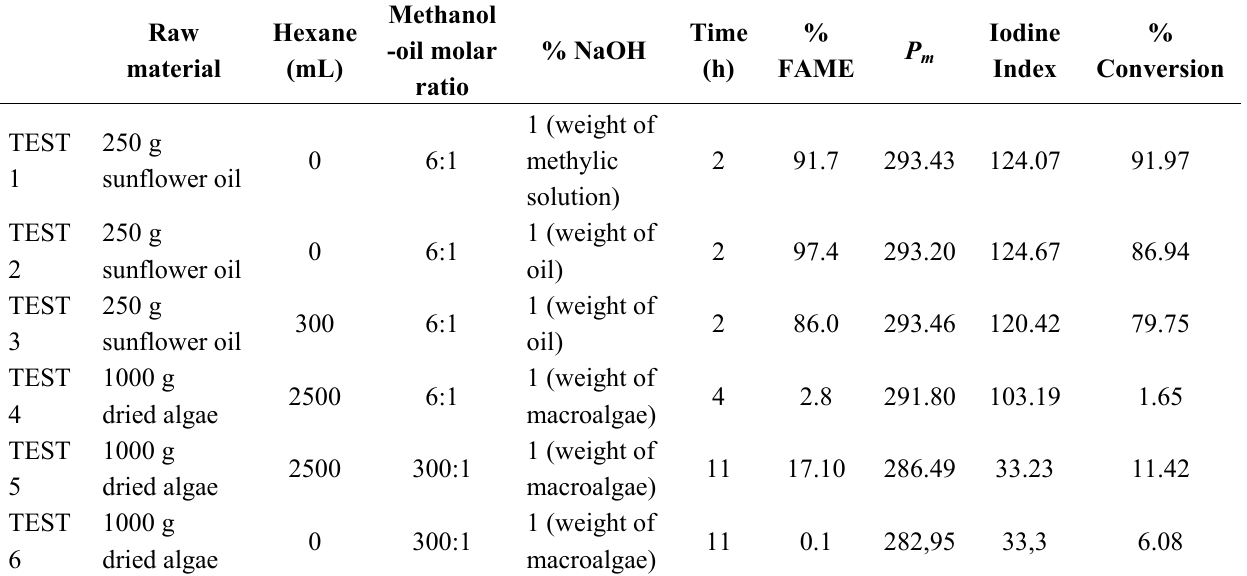
Table 5. Percentage of methyl esters, molecular weight, iodine index and biodiesel conversion in the all